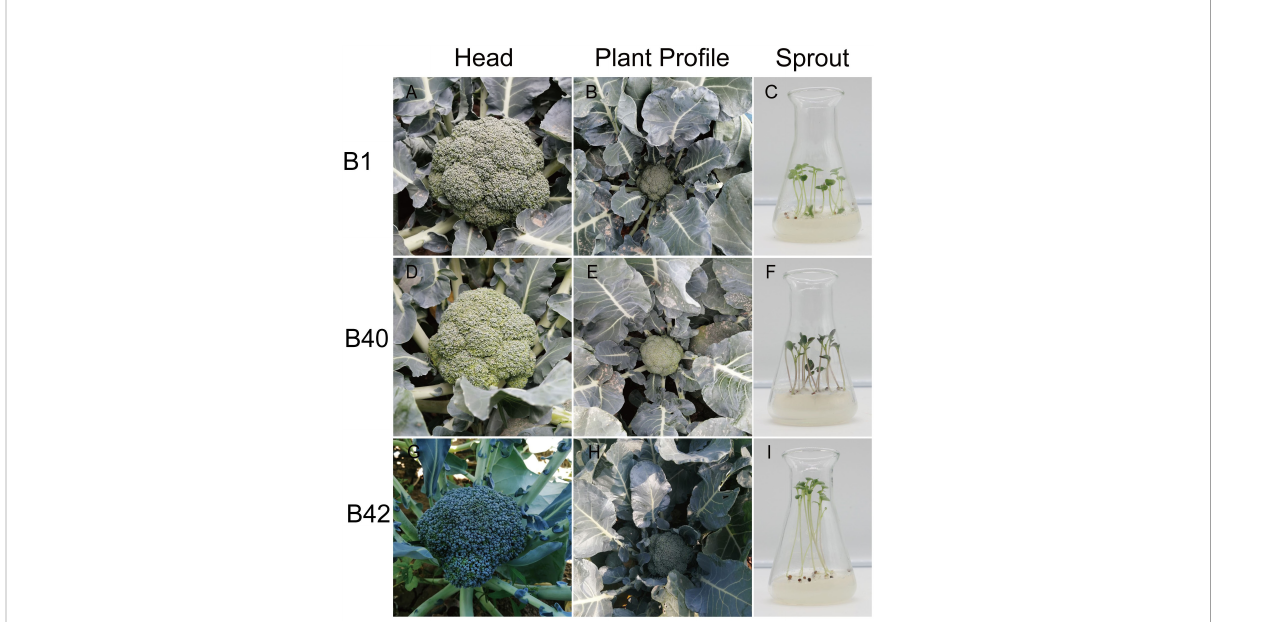
FIGURE 5 The pro fi les of broccoli plants and sprouts. (A – C) Head and plant pro fi les of B1 genotype broccoli plant. Representative healthy 10-day-old B1 broccoli sprout on seeding medium used for protoplast isolation. (D – F) Head and plant pro fi les of B40 genotype broccoli plant. Representative